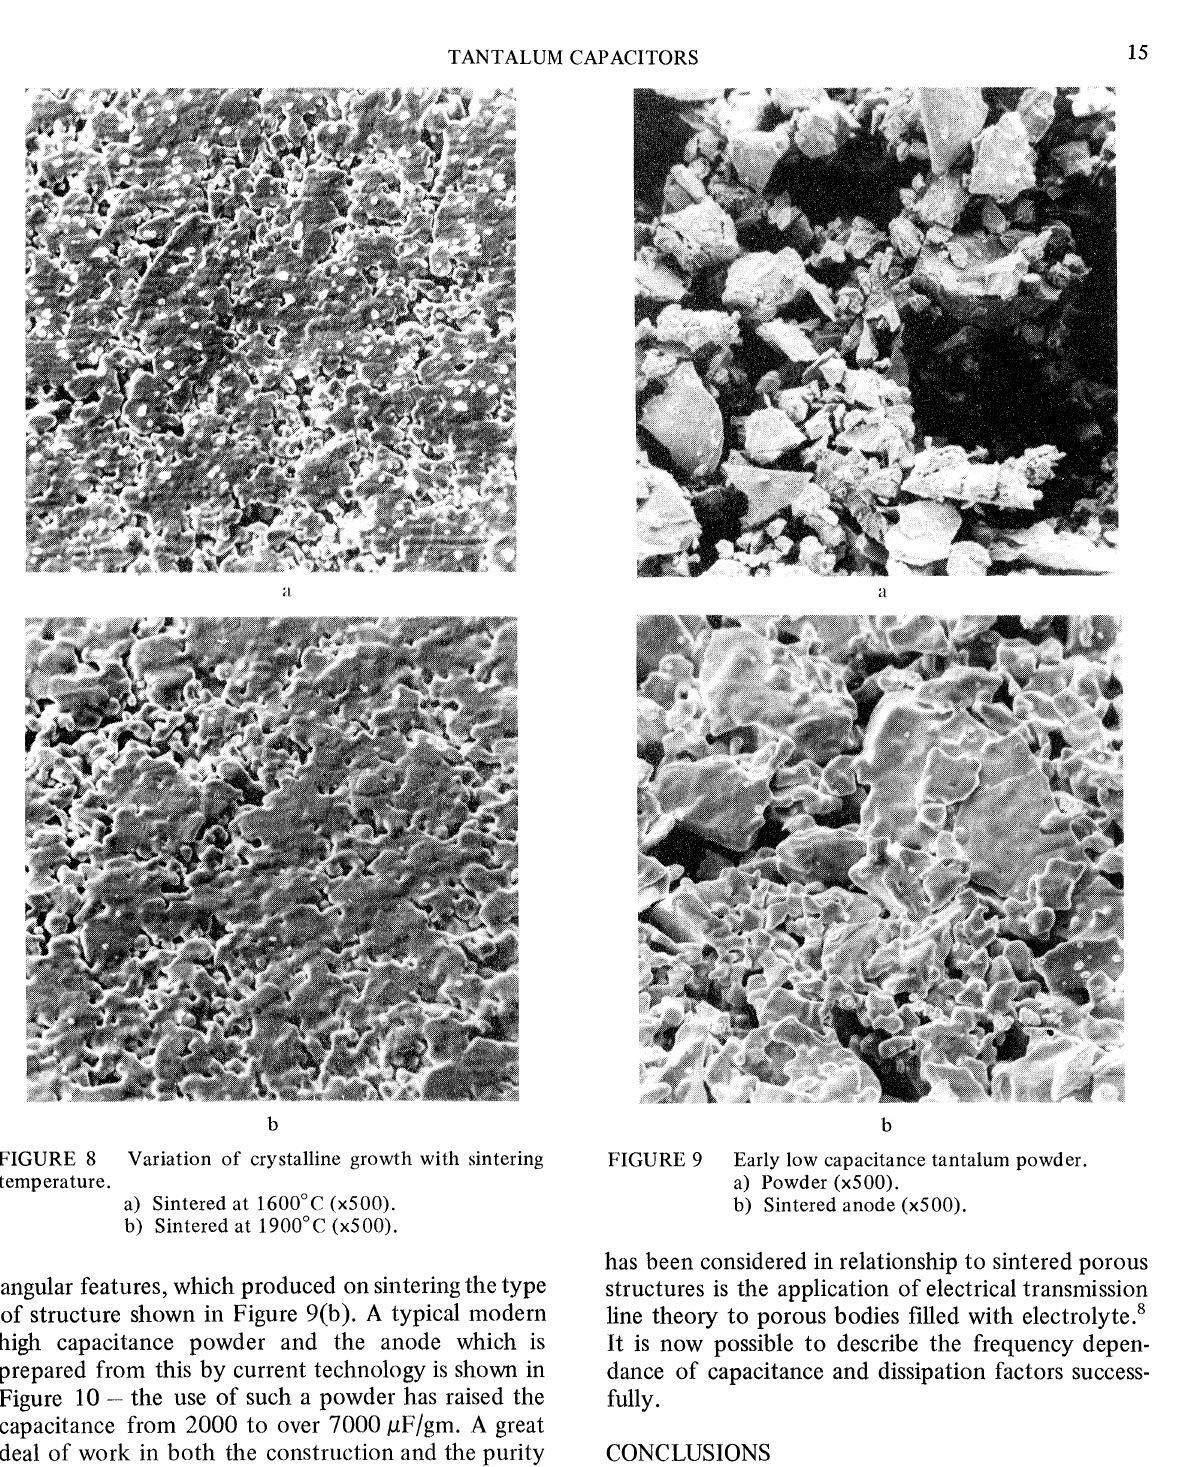
b FIGURE 8 Variation of crystalline growth with sintering temperature. a) Sintered at 1600C (xS00). b) Sintered at 1900 C (x500).